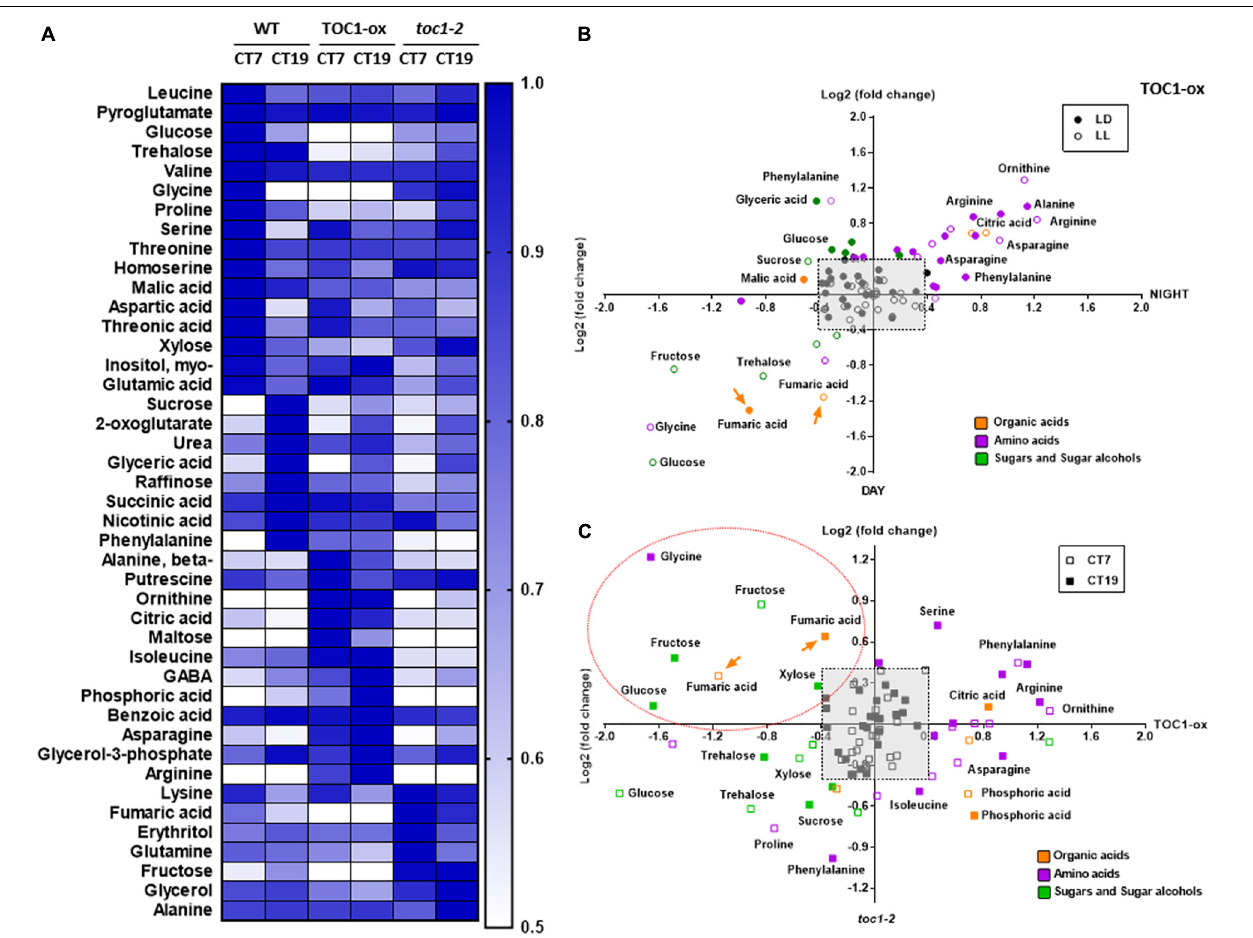
FIGURE 3 | TIMING OF CAB EXPRESSION1 regulates the diurnal and circadian accumulation of metabolites. (A) Heat map of GC-MS-analyzed metabolites in WT, TOC1-ox and toc1-2 plants. Plants were entrained under 12 h light: 12 h dark cycles and then transferred for 2 days to LL before sampling at CT7 and CT19. (B) Dispersion plots of metabolite fold change (day versus night) under LD (12 h light: 12 h dark cycles) and LL (subjective day versus subjective night) in TOC1-ox relative to WT. (C) Dispersion plots of metabolite fold change ( toc1-2 versus TOC1-ox) under LL. Metabolites were clustered per class into organic acids (orange), amino acids (purple), and sugars and sugar alcohols (green). Relative metabolite content was normalized to the mean of WT plants and fold-change values were log2 transformed. Log2 fold differences < [0.4] were not considered (pale gray square). Orange dotted oval denotes metabolites down-regulated in TOC1-ox and up-regulated in toc1-2 . Data are the result of 3–5 biological replicates, with plants grown independently at different times.